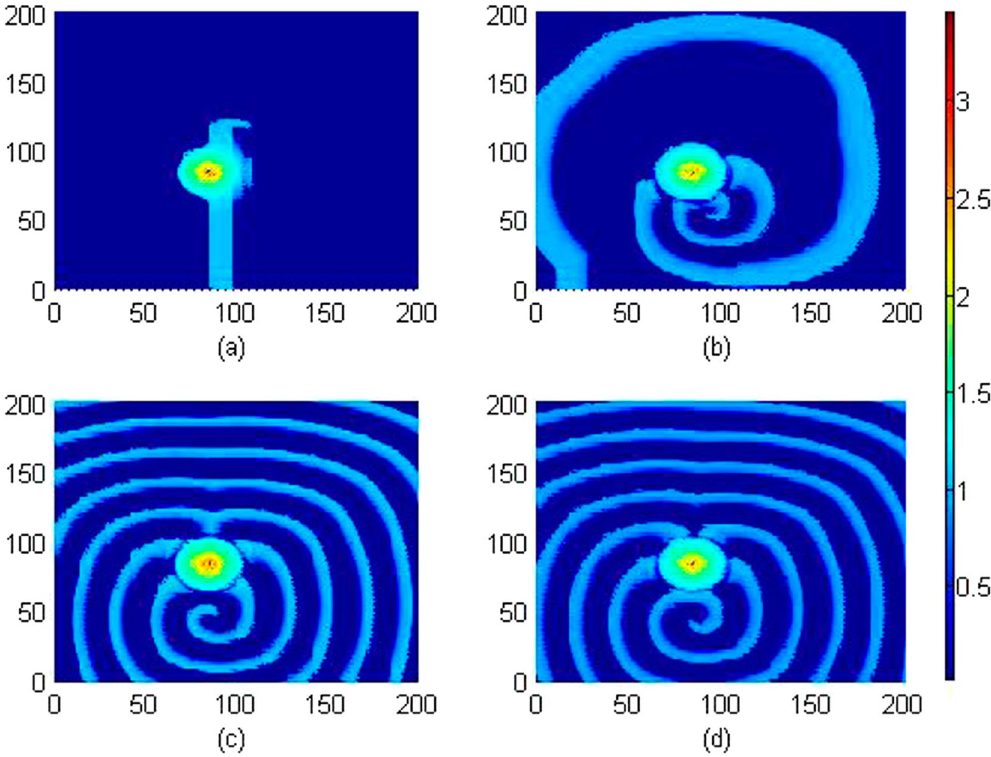
Figure 11. Developed spatial pattern is plotted for the media by setting wedge-shaped initial values, and the center of area exposed to electromagnetic field is selected as ( x 0 , y 0 ) = (84,84), at A = 12, m = 0.06, k 0 = 0.1, k 1 = 0.5, k 2 = 1.6, α = 1, β = 2. For t = 10 ( a ), 120 ( b ), 600 ( c ), 800 ( d ) time units. The snapshots are plotted in color